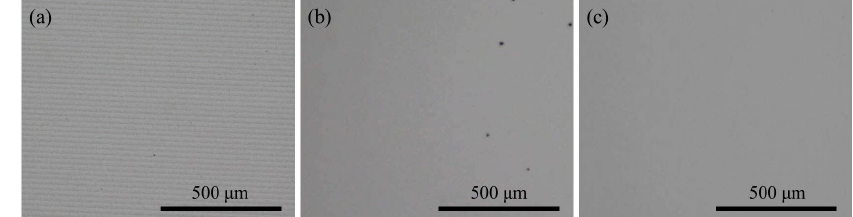
Figure 4. Surfacial topographies of KDP samples: ( a ) KDP sample after SPDT; ( b ) KDP sample after CMP with traditional W/O microemulsion; and ( c ) KDP sample after CMP with KDP aq/O microemulsion.